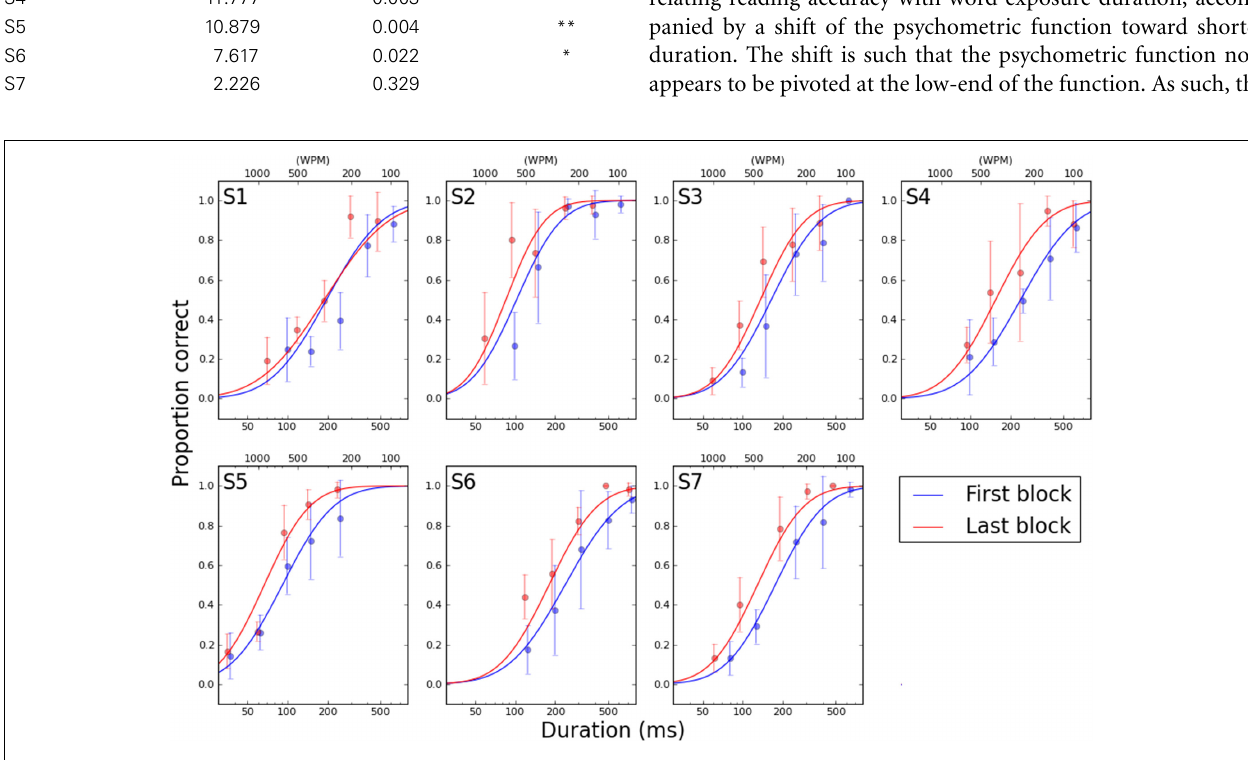
speed in words per minute on the top axis. Points show the mean and standard deviation of the six repetitions of each word duration in the specified